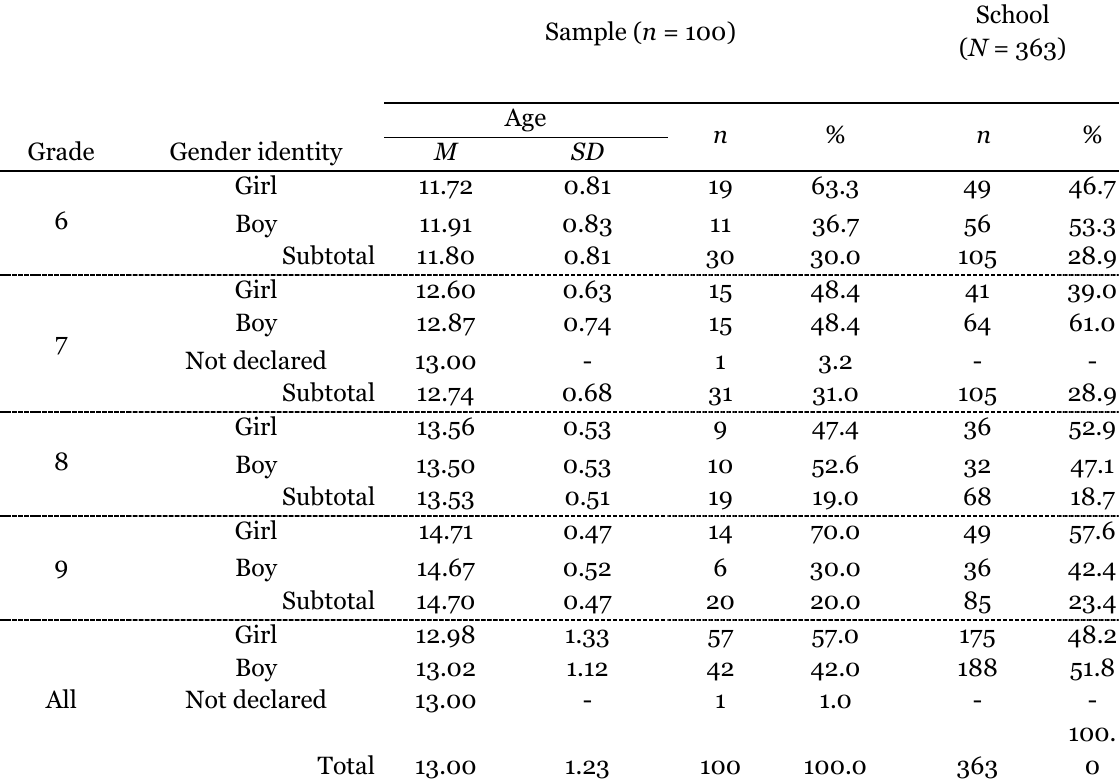
Sample Description—Age and Gender Identity by Grade